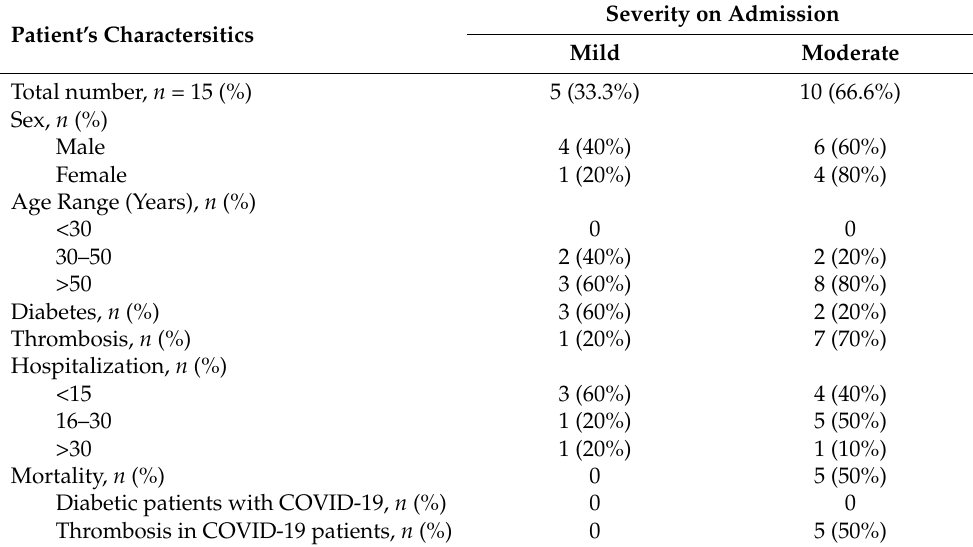
Table 4. Characteristics of COVID-19 patients assessed for plasma